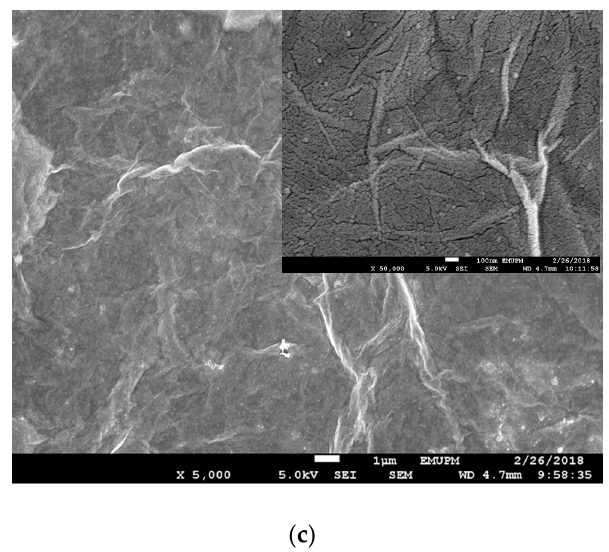
Figure 2. Field emission scanning electron microscope (FESEM) images of ( a ) PVA nanofibers, ( b ) PVA/PEDOT nanofibers and ( c ) rGO. Inset: high magnification of ( b ) PVA/PEDOT nanofibers and ( c ) rGO.